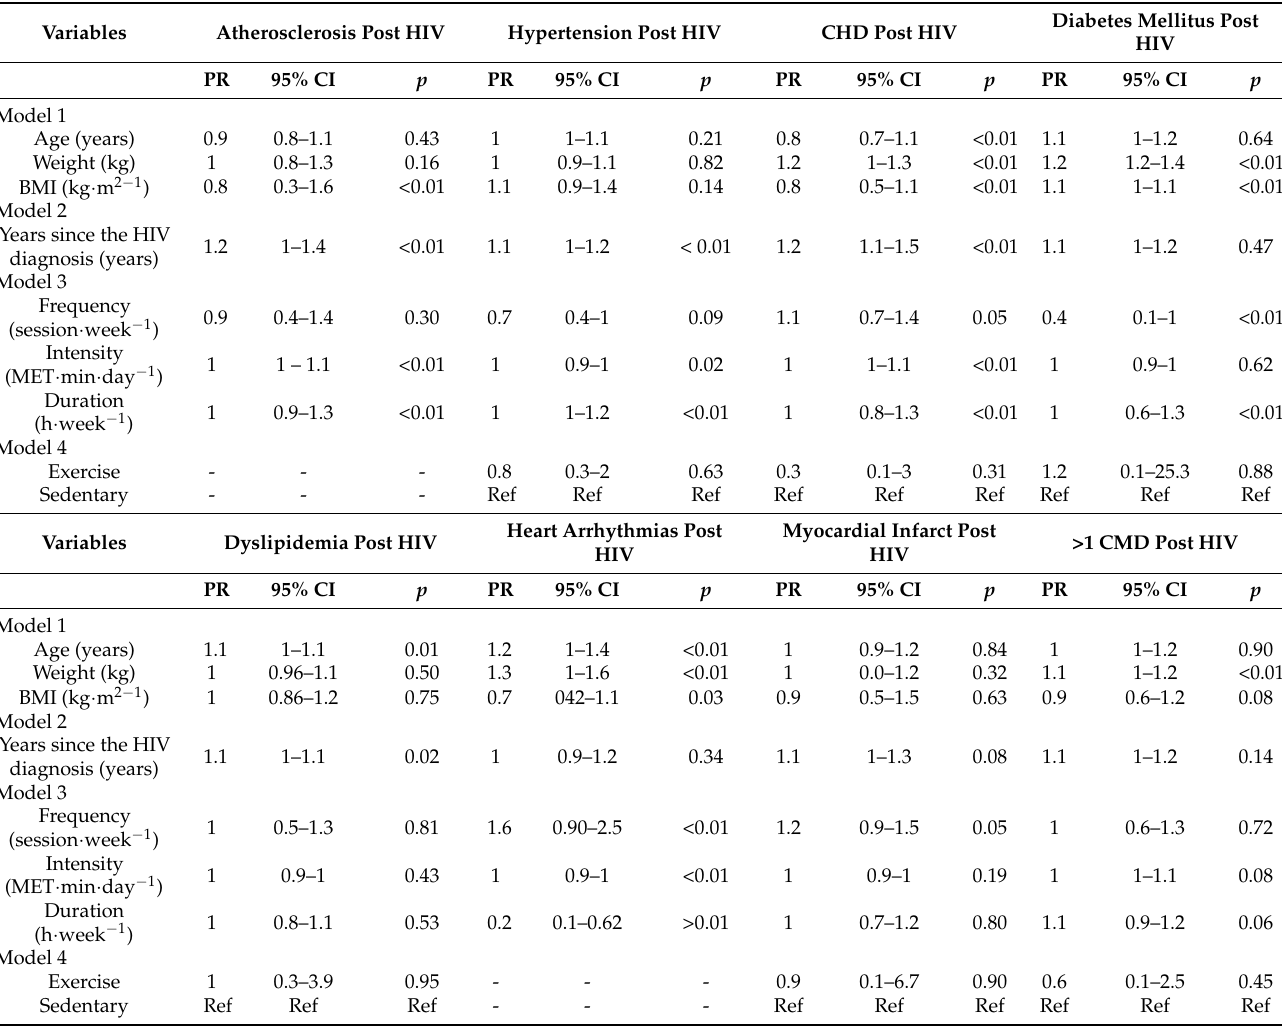
Table 4. Risk of reporting CMDs in relation to anthropometric characteristics, HIV and ART, EXC characteristics, and exercise in German